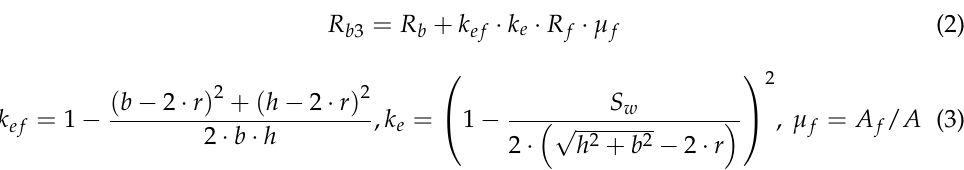
Figure 18. Influence of the load application eccentricity on the change in the composite gain k f . At an eccentricity of e 0 = 2 cm (0.16 h), the efficiency of the solid clip decreased by a factor of 2 and became comparable with the combined longitudinal reinforcement of the stretched zone. At e 0 = 4 cm (0.32 h), the effect of the solid cage remained practically unchanged, while the value of the longitudinal reinforcement of the stretched zone, on the contrary, increased sharply and exceeded the efficiency of the solid cage for short